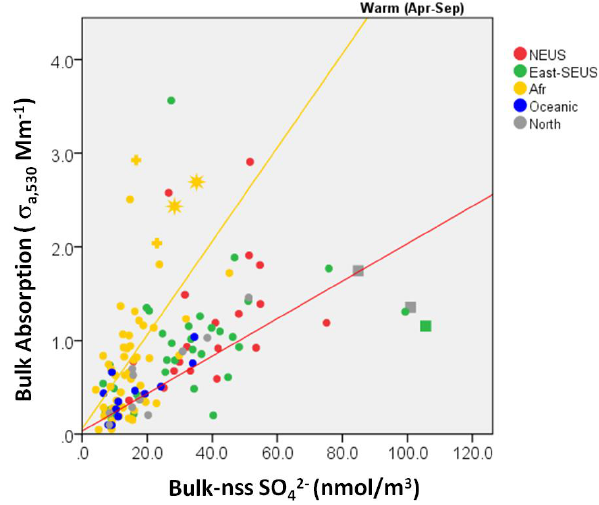
Fig. 7. Sectored bulk σ a , 530 versus bulk nss SO 2 − concentration 4 associated with each of the source region flow patterns during the warm season, with specific events highlighted: asterisks mark the African dust event from 28 June and 1 August 2006; crosses mark the dust event from 21 and 23 April 2009; squares mark the polluted haze/biomass burning event from North and East–SEUS, 18, 19 and 20 June 2007. Regression lines are plotted for NEUS, r = 0 . 49 with intercept of 0.03 and slope of 0.02, and for AFR, r = 0 . 56 with intercept of 0.06 and slope of 0.05.